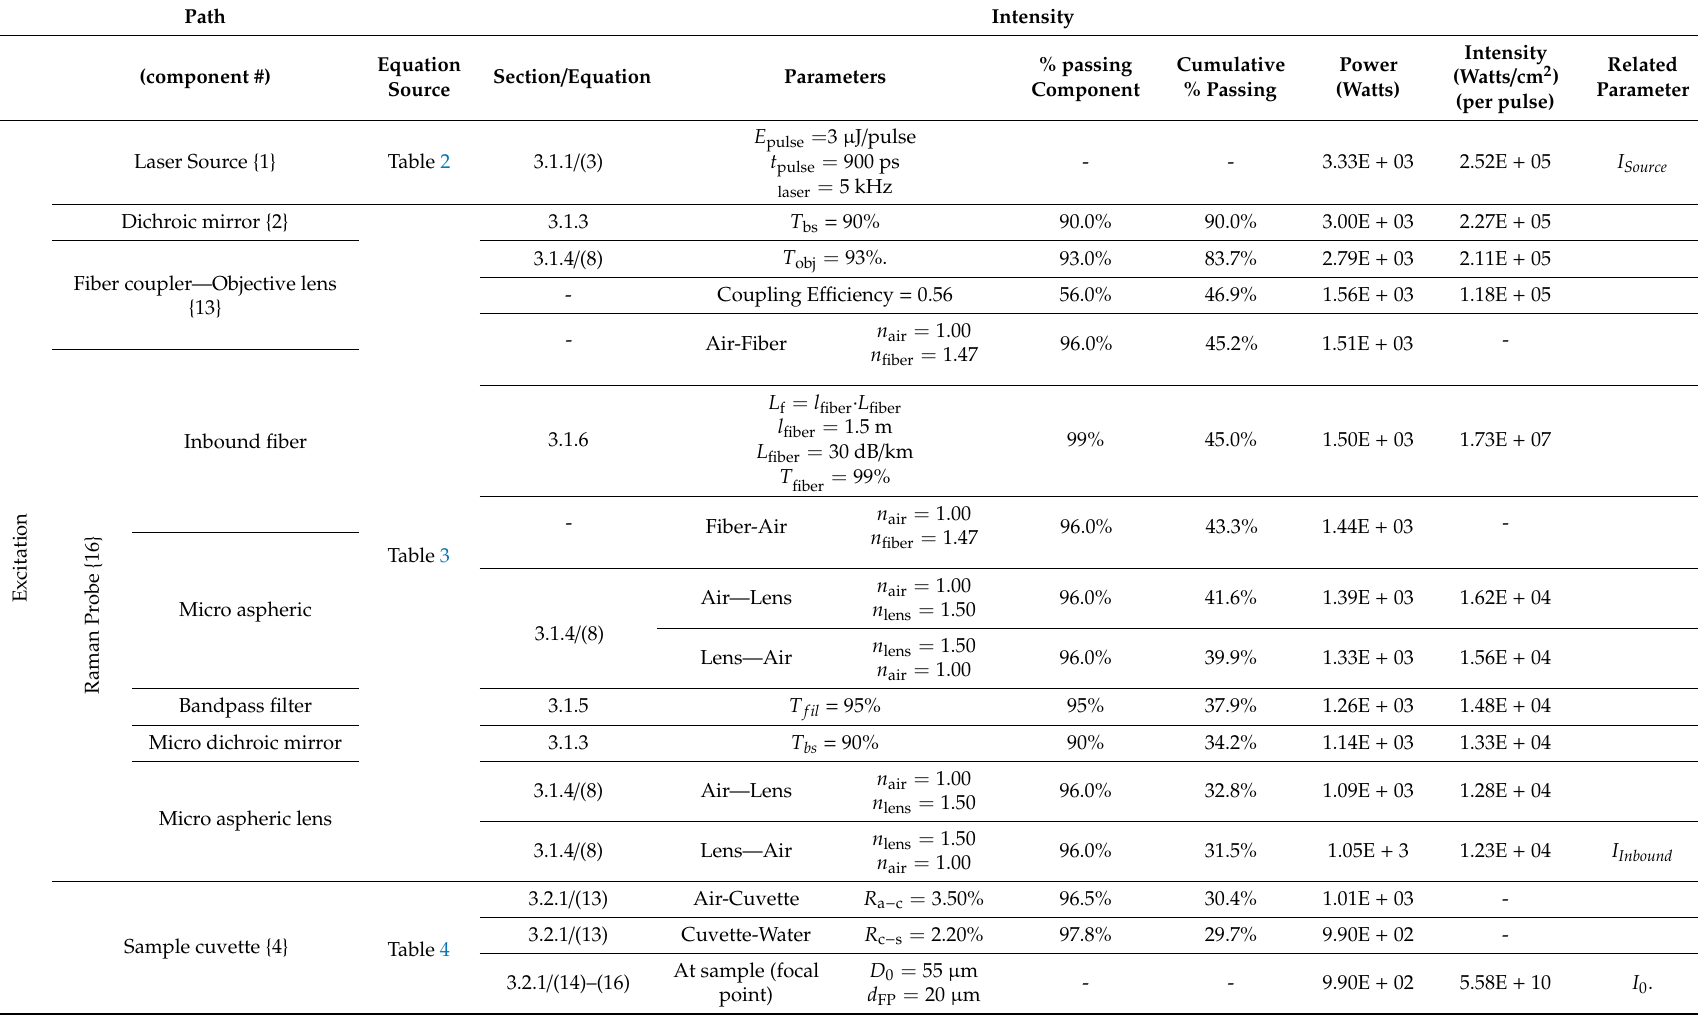
Table 10. Purdue CE Spectroscopy Lab 532 nm closed-path TRRS example intensity